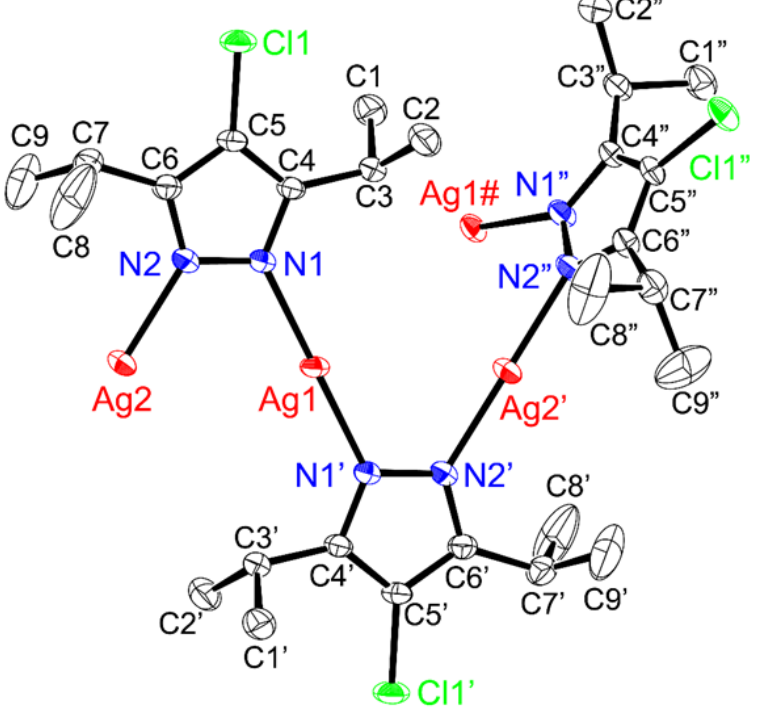
Figure 3. Crystal structure of [Ag(μ -L1Clpz)] n showing 50% displacement ellipsoids and the atom labeling scheme. Hydrogen atoms were omitted for clarity. Relevant bond lengths (Å) and angles